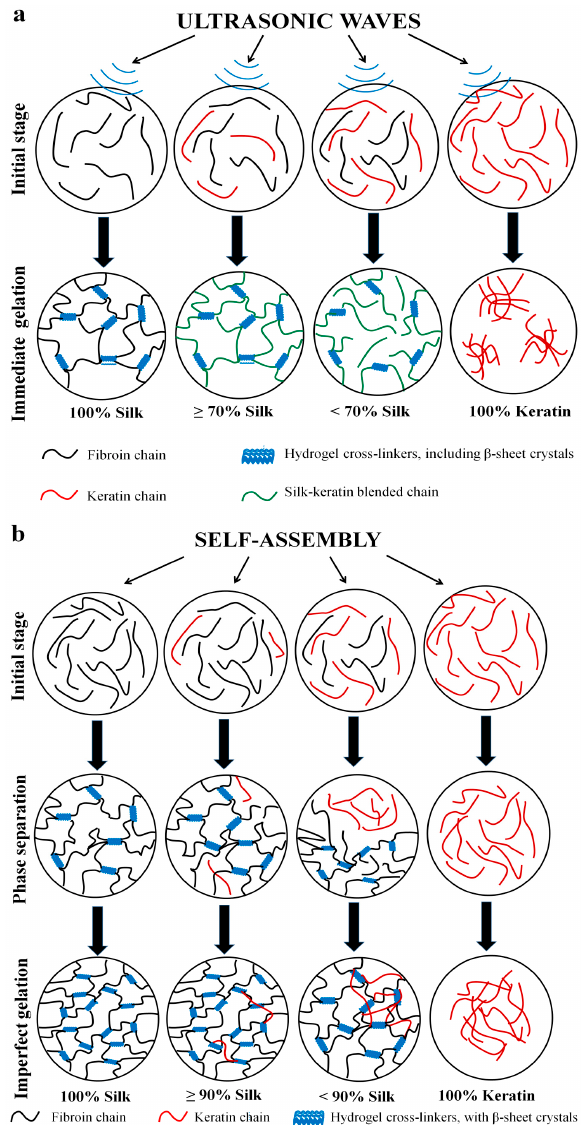
Figure 6. Hydrogel formation and structural mechanism for: ( a ) Ultrasonication-induced silk/keratin hydrogels. Row 1: Initial blends of silk fibroin and wool keratin during sonication, with pure silk and pure wool solution as controls; Row 2: After quick sonication, β -sheet crystals form cross-linkers immediately, entrapping keratin and silk chains at both the nano- and microscale. The blends have a homogeneous silk/wool gel structure when there is at least 70 wt % of silk (30 wt % of wool keratin). Below 70 wt % of silk, homogenous blend solutions cannot form continuous gel structures due to a lack of cross-linkers; ( b ) Naturally self-assembled silk/wool hydrogels. Row 1: Initial blend solutions of silk fibroin and wool keratin, with pure silk and pure wool solution as controls; Row 2: after a long suspension, macrophase separation of protein chains may occur at the nanoscale, with silk chains starting to form cross-linkers through self-assembled beta-sheets crystals; Row 3: After 12 h, solutions with less than 90 wt % silk (10 wt % wool or less) started to exhibit an imperfect gelation network.